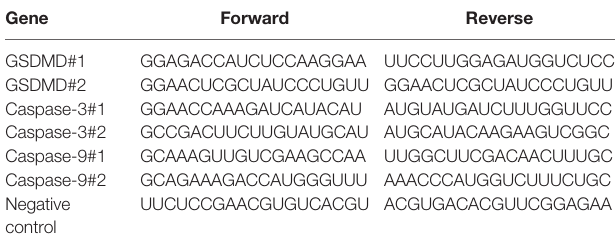
TABLE 1 | Related siRNA sequences used in the experiment. Gene